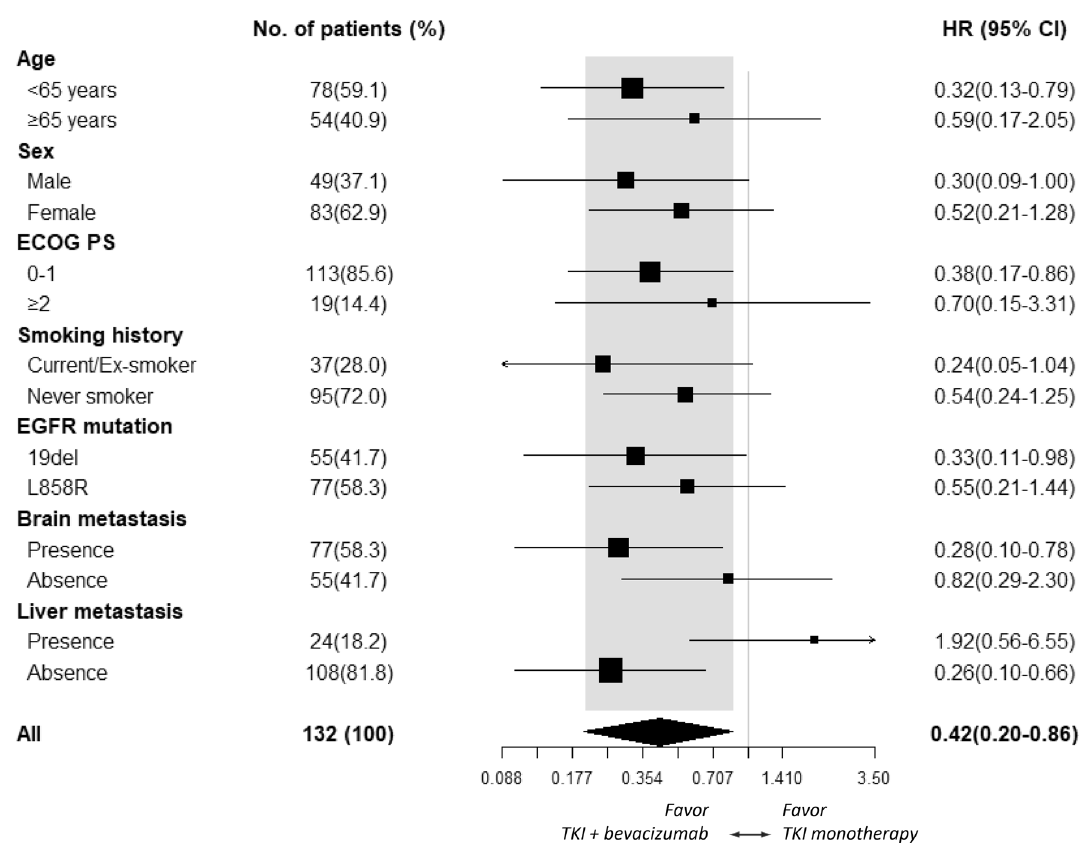
Figure 2. Subgroup analysis of OS of EGFR-TKI plus bevacizumab and EGFR-TKI monotherapy